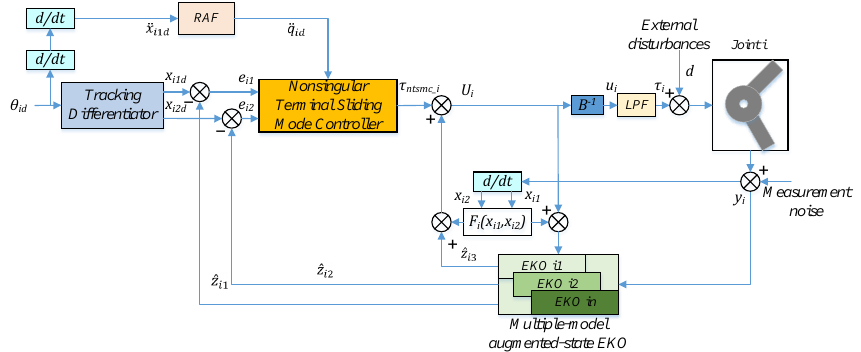
Figure 2. Block diagram of the